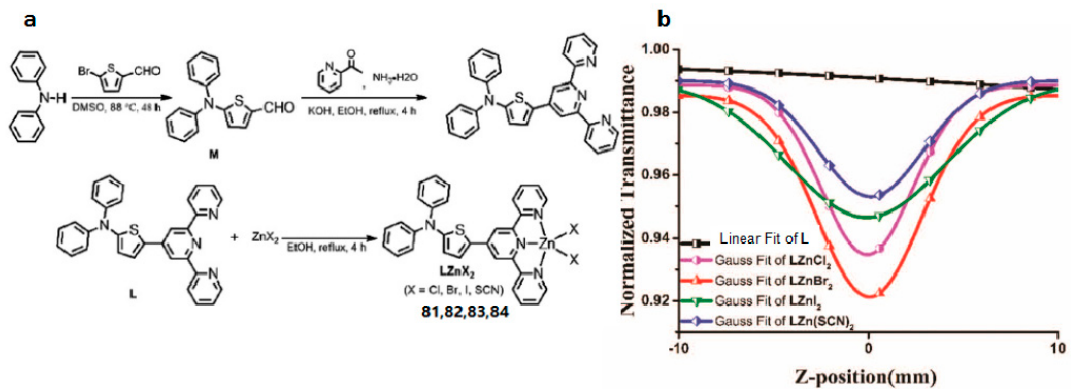
Figure 20. ( a ) Synthetic route for ligand L and complexes LZnCl 2 ( 81 ), LZnBr 2 ( 82 ), LZnI 2 ( 83 ), and LZn(SCN) 2 ( 84 ); ( b ) Theoretical curves of representative open-aperture Z-scan traces at wavelengths corresponding to a maximum nonlinear absorption for L, LZnCl 2 ( 81 ), LZnBr 2 ( 82 ), LZnI 2 ( 83 ), and LZn(SCN) 2 ( 84 ) at 850 nm.